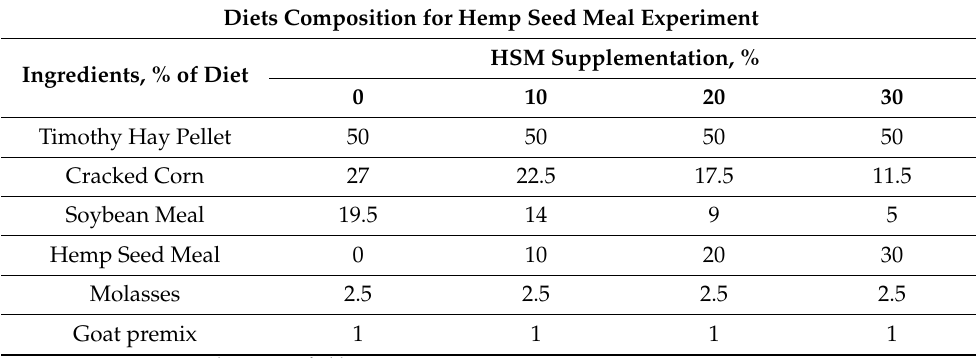
Table 1. Diet composition of experimental diets utilized in 60-day feeding period. Diets Composition for Hemp Seed Meal Experiment Ingredients, % of